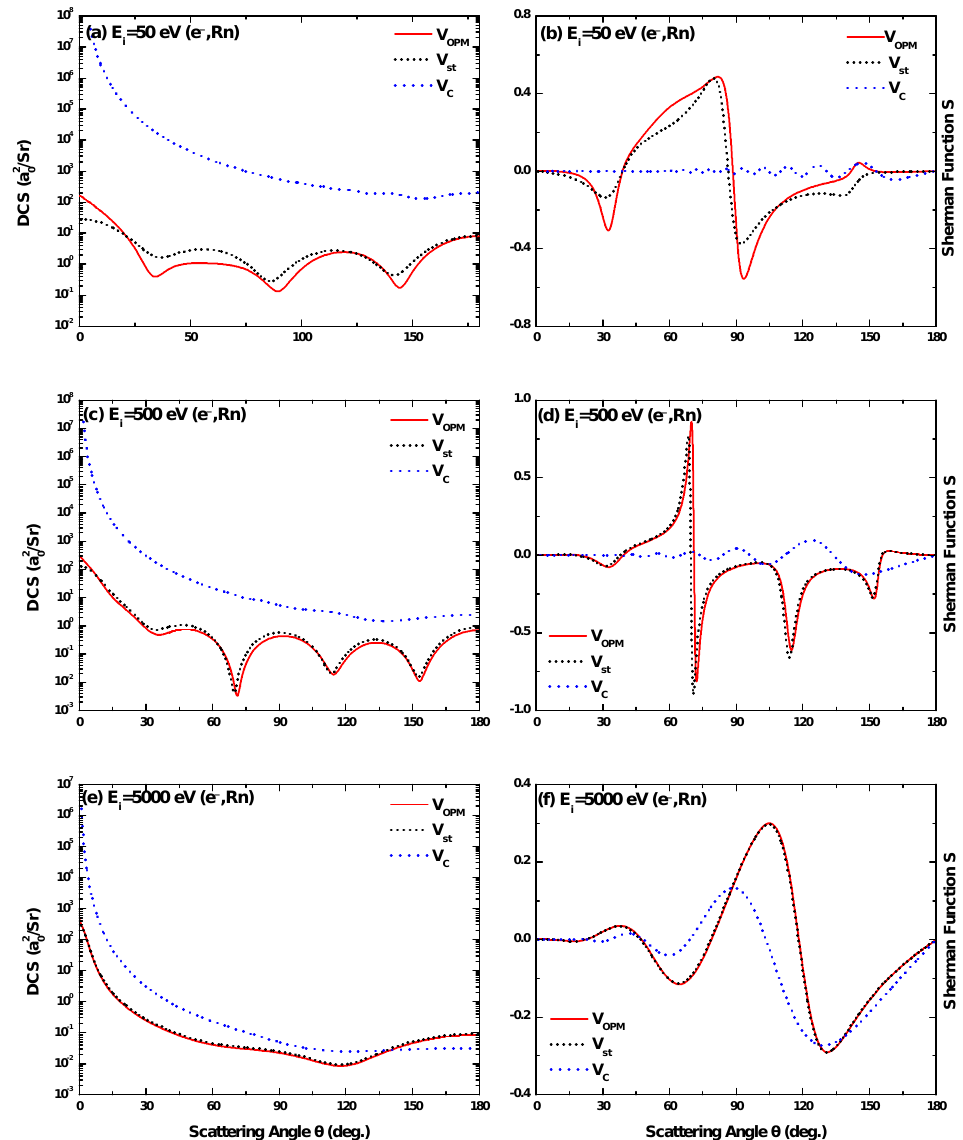
Figure 3. Angular dependence of ( a , c , e ) the DCS and ( b , d , f ) the Sherman function for electrons at 50 eV ( a , b ), 500 eV ( c , d ) and 5000 eV ( e , f ) colliding with 222 Rn. Shown are the results from V st ( · · · , black) and V opt (——, red). Included also are the results for the Coulomb field V c ( · · · ,